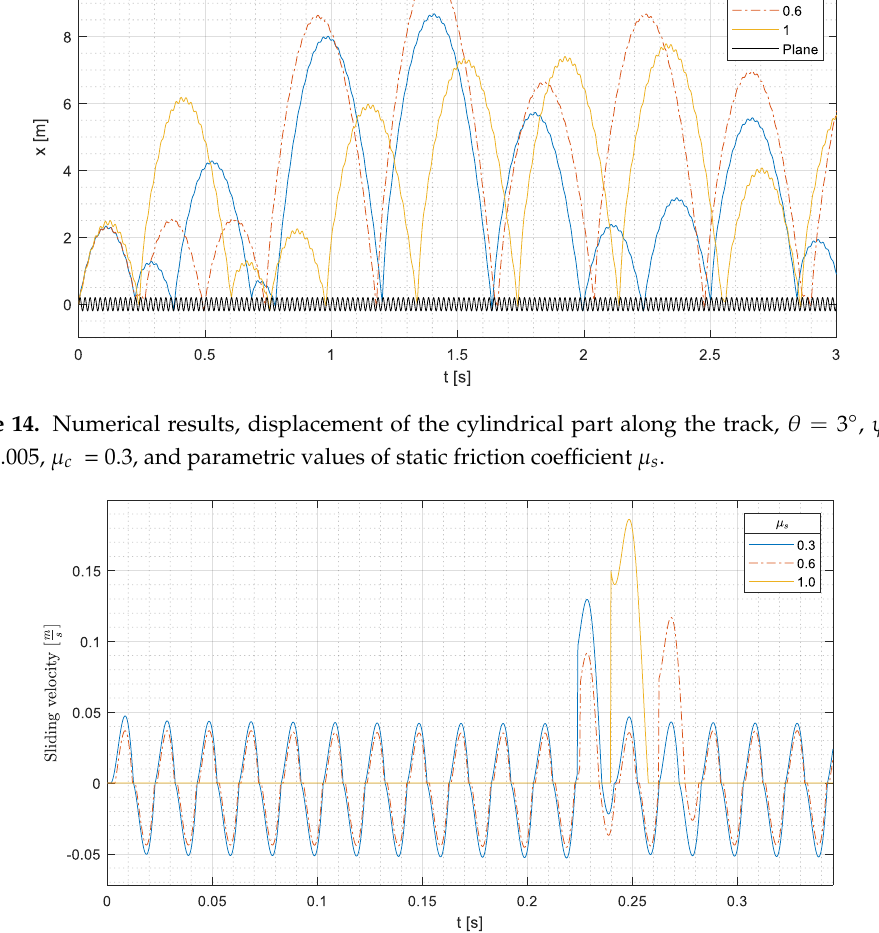
Figure 16. Numerical results, displacement of the cylindrical part along the track, 𝜃 = 3° , 𝜓 = 0 , 𝑓 𝑣 = 0.005 , and parametric values of static friction coefficients 𝜇 𝑐 and 𝜇 𝑠 .